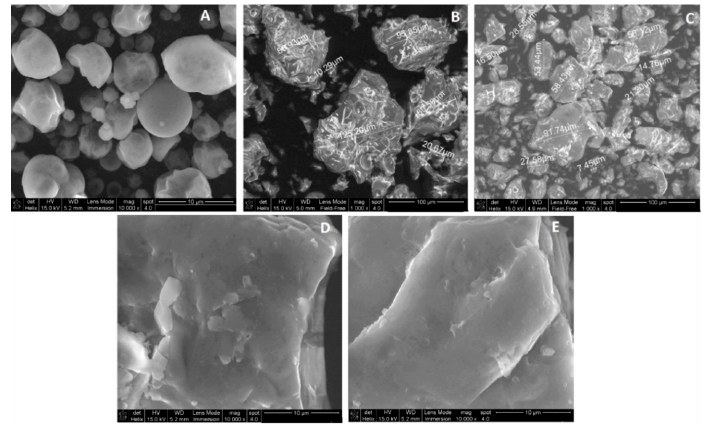
Figure 1. ( A ) Scanning electron microscopy (SEM) analysis at 10,000× of lyophilized black bean extract, and ( B , C ) black bean capsule formulations using 25% of maltodextrin with 24.1% of microcrystalline cellulose 50, 50% of starch and 0.9% of magnesium stearate (powder B) or with 74.1% of starch and 0.9% of magnesium stearate as excipients (powder C) and ( D , E ) at 1000× for powder B and C.